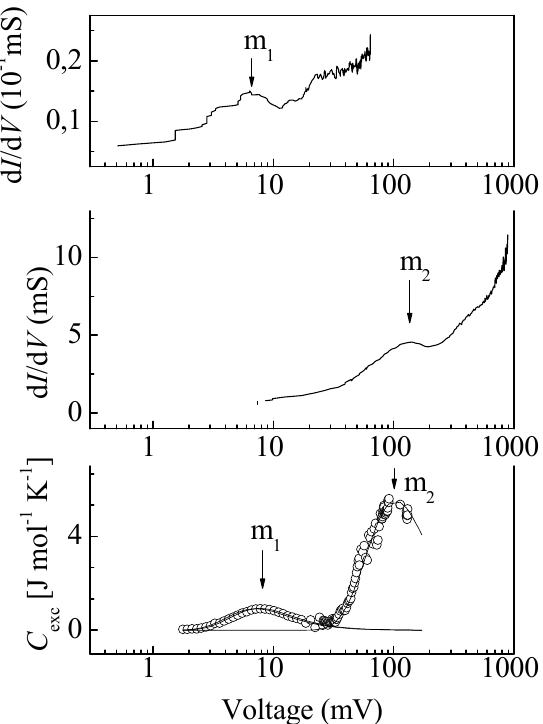
Figure 4. Visual comparison of the local and averaged tunnel spectra obtained in [32] and the excess electronic specific heat obtained in [25]. Arrows indicate features similar in shape and energy.